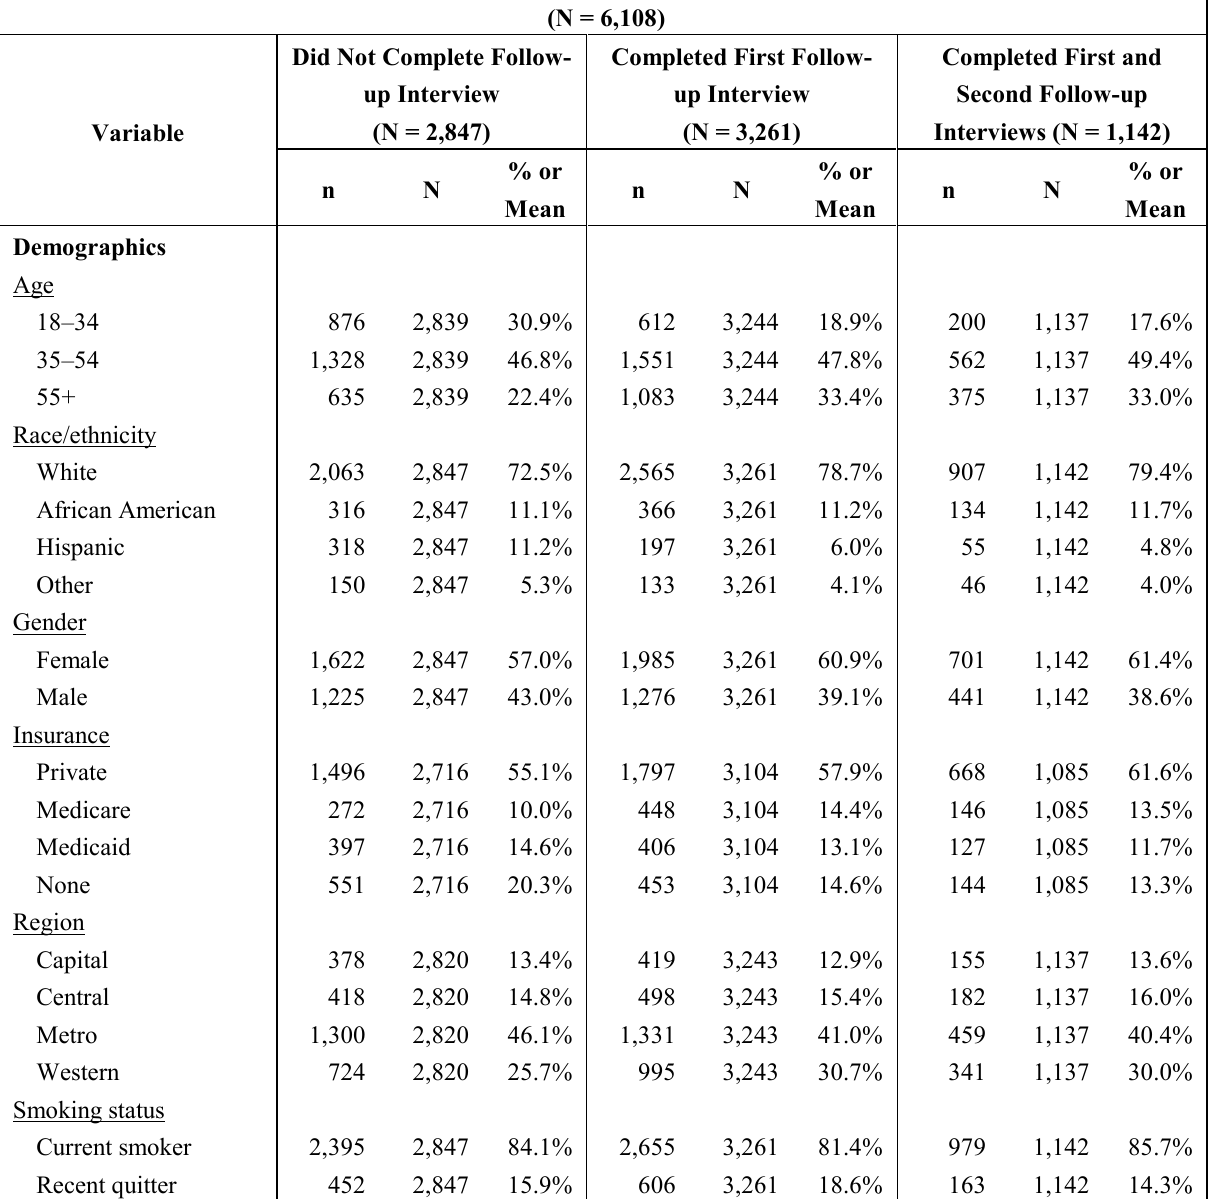
Table 1. Characteristics of participants in the Adult Cohort